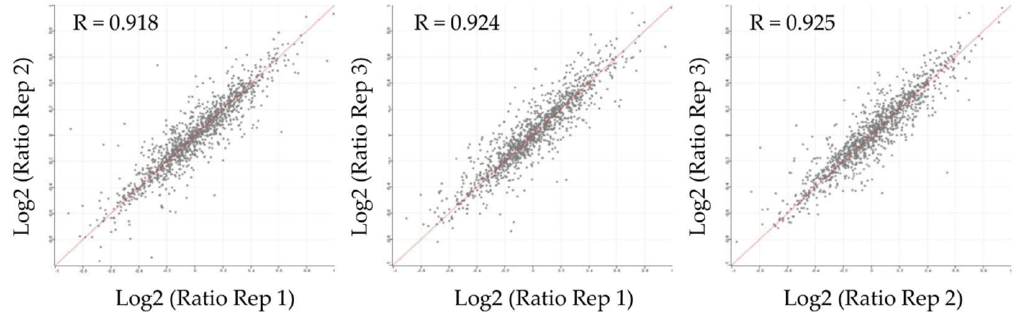
Figure 3. Correlation analysis of protein ratios between biological replicates of EVs. Log2-transformed protein ratios (dT/pT) of each biological replicate were plotted against each other and Pearson′s correlation coefficients (R) were calculated.